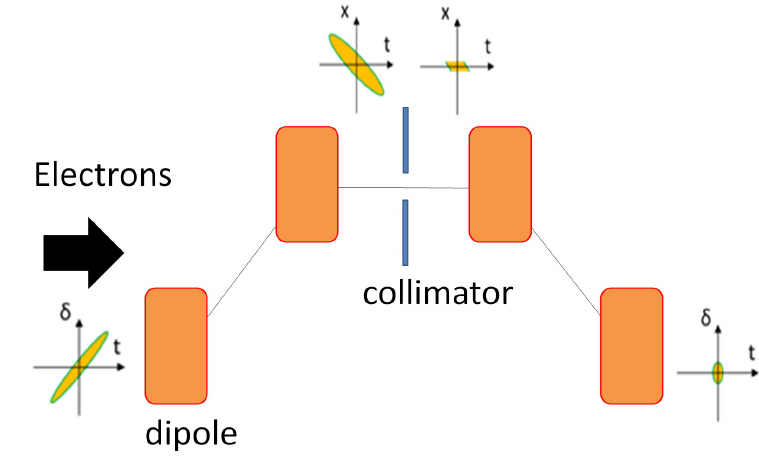
Figure 5. Working principle of the longitudinal collimation method in magnetic bunch